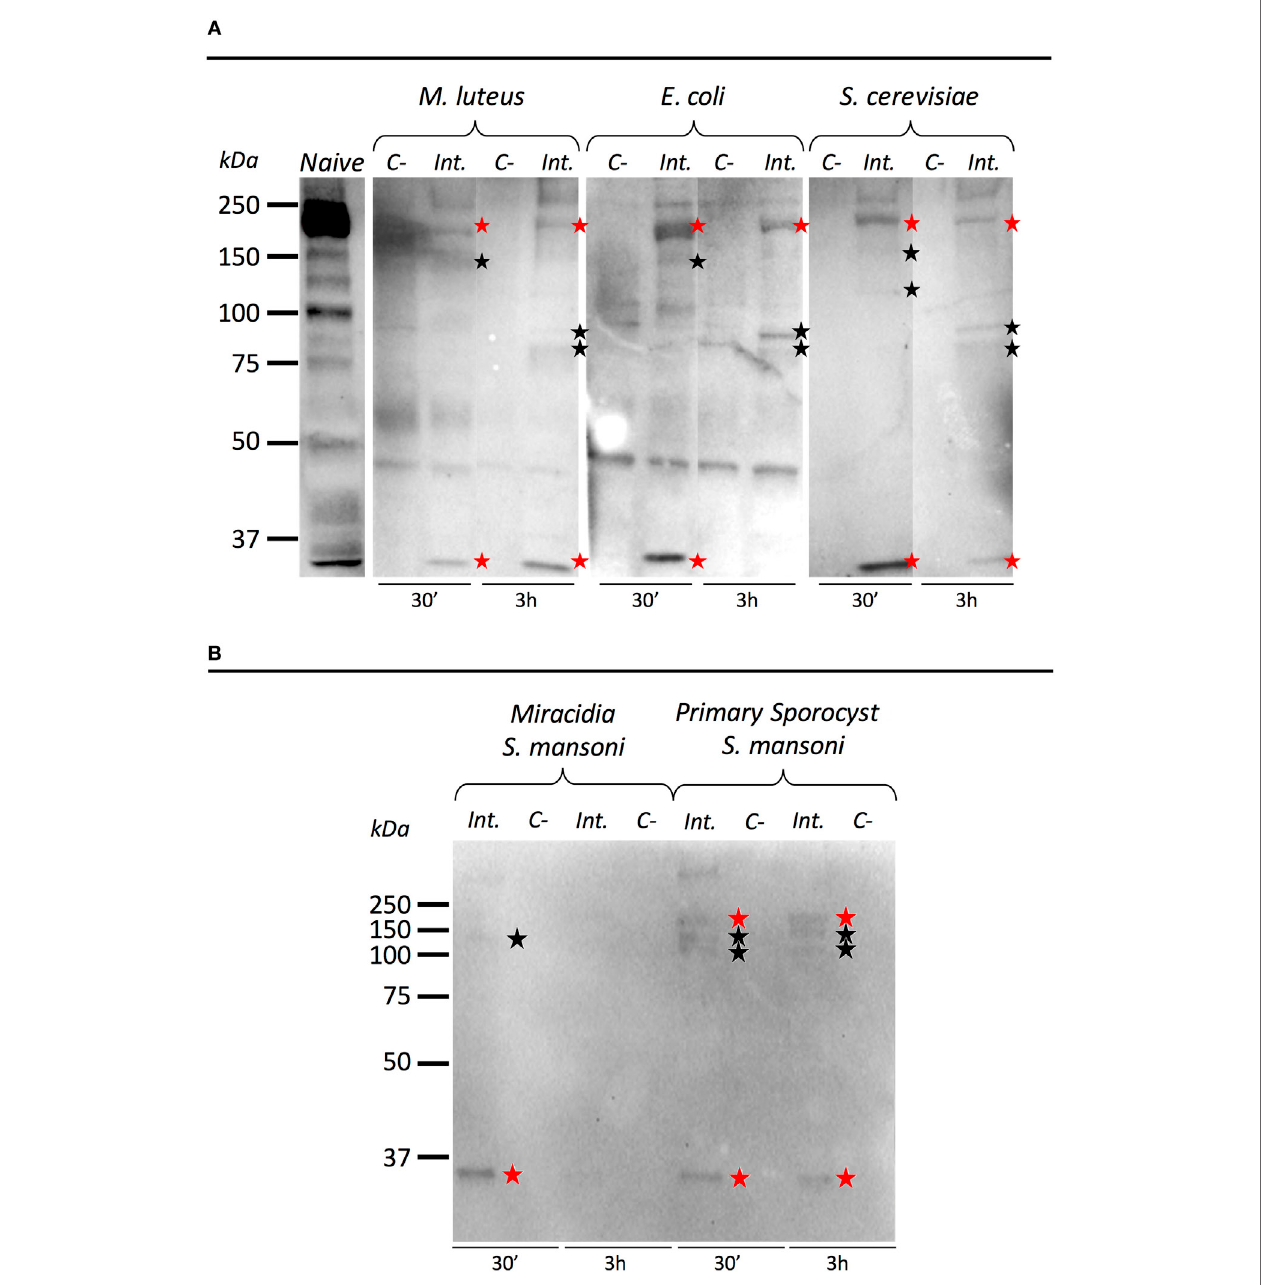
FigUre 6 | Immunoblotting analysis of BgTEP. Live intruders interaction with Biomphalaria glabrata cell-free hemolymph was monitored by Western blot using anti-BgTEP-RP antibody. Ultracentrifuged cell-free hemolymph from naïve snail was used as positive control for full-length and processed forms detection of BgTEP. For each interaction condition, negative control (C − ) corresponds to the intruder alone, interactome (Int.) corresponds to the interaction between the intruder and B. glabrata cell-free hemolymph. Red stars correspond to putative full-length (200 kDa) and cleaved protein (about 30 kDa) observed in all interactions, and black stars indicate bands between 75 and 150 kDa corresponding to BgTEP alternative processed forms. (a) Comparison of BgTEP binding and time-dependent processing after 30 min and 3 h of interaction between cell-free hemolymph and Micrococcus luteus , Escherichia coli , and Saccharomyces cerevisiae . (B) Comparison of BgTEP binding between two developmental stages of Schistosoma mansoni (miracidia and primary